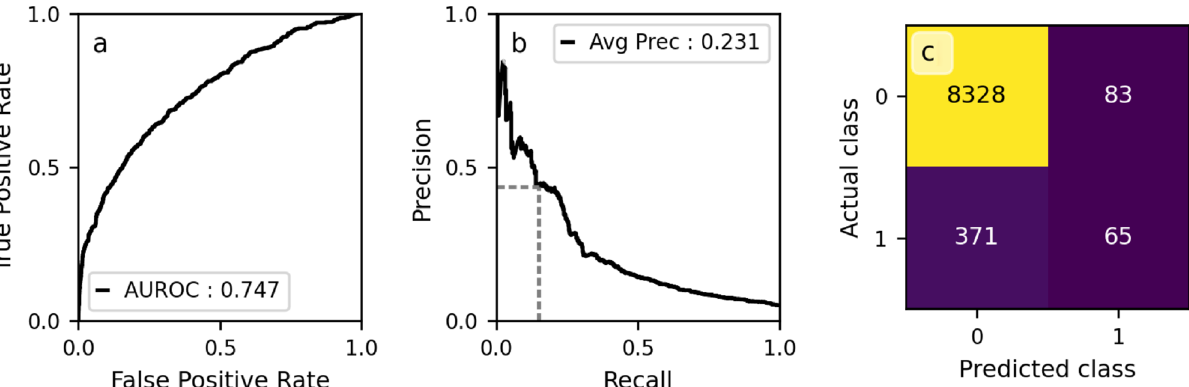
Figure 2. Performance of our model (model p in Table 3) evaluated on the hold-out test set. ( a ) Receiver operating characteristic curve for model’s predictions. ( b ) Precision recall curve, the dashed grey line shows the configuration evaluated in the confusion matrix in panel ( c ). ( c ) Confusion matrix for predictions dichotomized using a threshold chosen such that the recall is equal to 0.15 (dashed grey line in panel ( b )). A class of ‘1’ indicates the patient reattended the emergency department within 72 h of discharge. Diagonal elements represent correct classifications and off-diagonal elements either False positives or